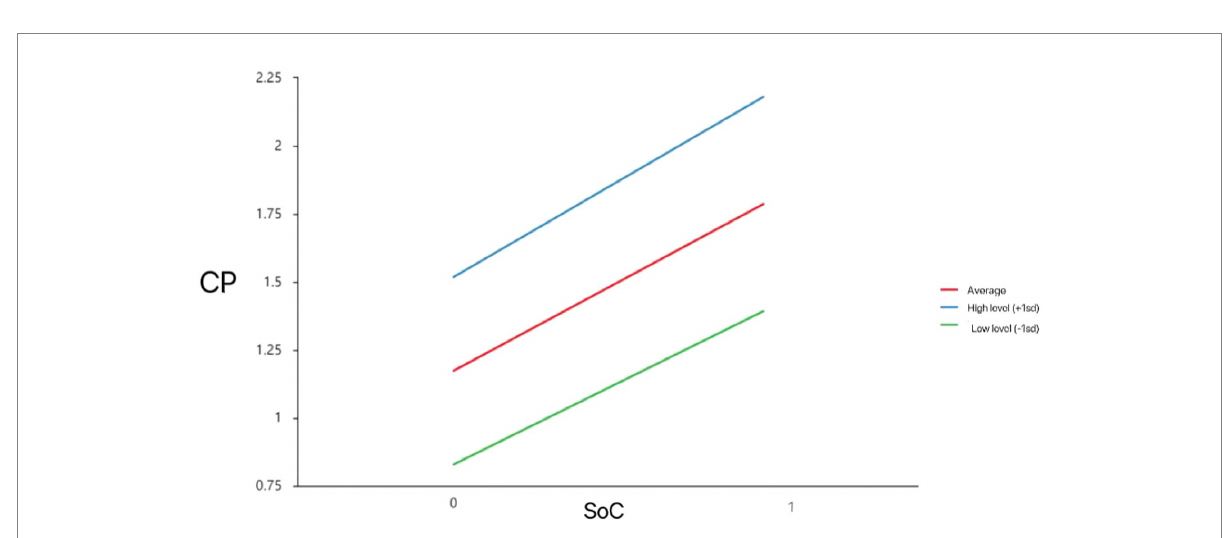
FIGURE 3 Model of test for simple slopes showing moderating influence of SS on association between SoC and CP.